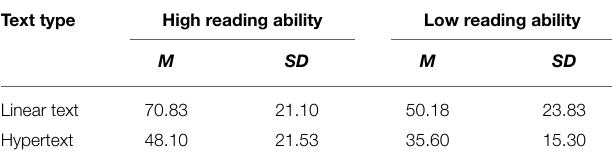
TABLE 6 | Mean and SD values of online-reading problem-solving task scores for students with different reading abilities reading different types of